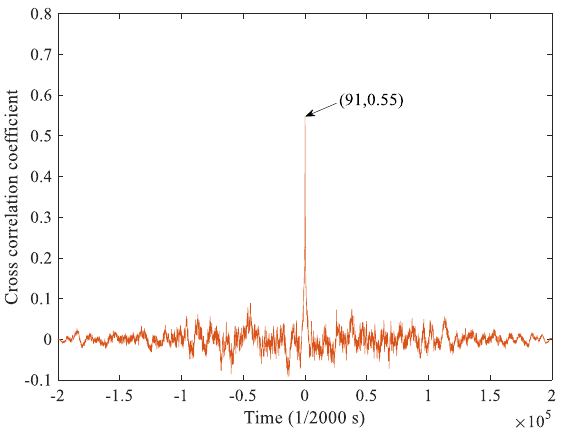
Figure 10. The result of the cross correlation coefficient between the two probes.